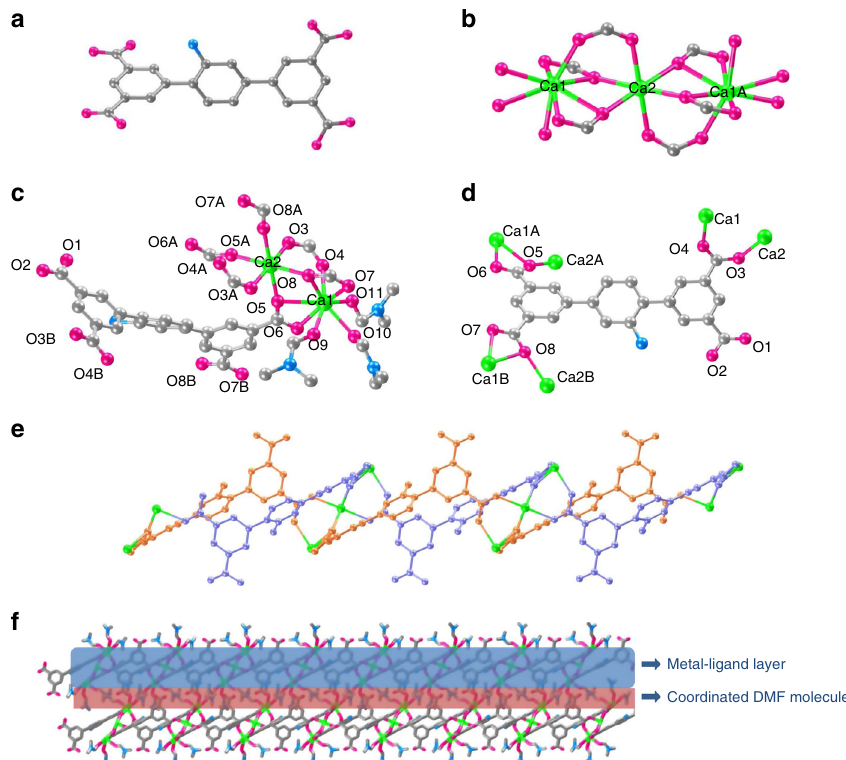
Fig. 1 Crystal structure of Ca – MOF. HL 3 − ligand ( a ), {Ca 3 O 18 } metal-oxygen cluster ( b ), coordination environment of Ca1 and Ca2 ions ( c ), coordination mode of HL 3 − ligand ( d ), Z -like metal-ligand chain viewed along b axis ( e , DMF molecules are omitted for clarity), and view of 2D metal-ligand coordination layers along b direction ( f ). Atom color: Calcium, green; Carbon, gray; Oxygen, pink; Nitrogen, blue; Hydrogen atoms are omitted for clarity. For e , orange and purple colors dictate atoms from different